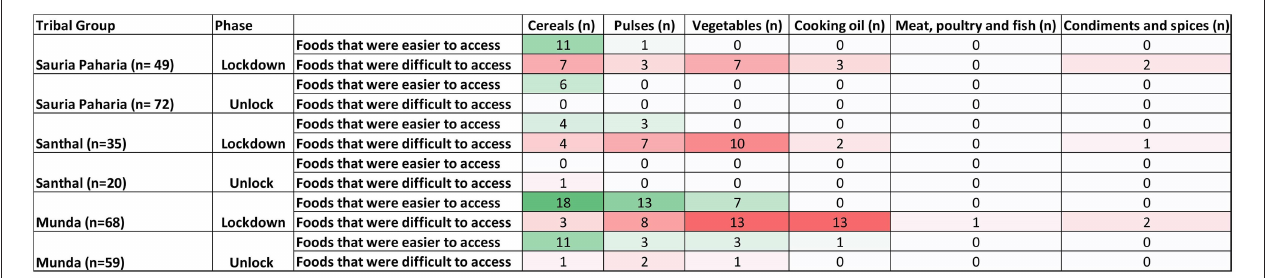
FIGURE 8 | Impact of COVID-19 pandemic on food access in different indigenous communities of Jharkhand, India.